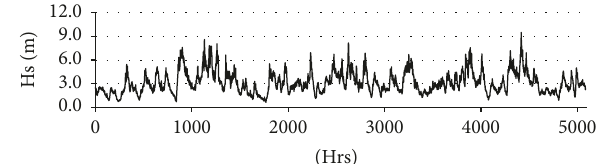
Figure 6: Plot of the September–April Hs time series of 09-10. Identified extremes: P 1